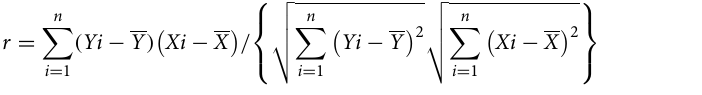
Figure 5. CaMKII phylogenetics (from 1D Sequences). ( a ). Metazoan CaMKII-AD evolution. Tree based on 1000 clustered homologs of the C. elegans CaMKII (black asterisk). Midge (pink asterisk). ( b ). Isoform evolution. Tree based on 2000 clustered homologs of the rat CaMKII α and β isoforms. Squares denote the most distant, larger CaMKIIα node (L) and the smallest y node with H:P ratios > H : P ± 2 s (1.5 ± 1.33), where H : P is the mean of the other nodes. Circles mark major clusters (diameter = membership; color = (i) phylum; (ii) isoform), Note difference in scale bar from that in Fig. S2C. ( c ) AD–KD coupling. The AD versus KD similarity plot compared the KD and AD phylogenetic trees color coded by isoform as in panel b (Box) The dual color symbols identify isoform pairs. The correlation coefficient, r = 0.59 with the best-fit (solid line) ± 95% confidence intervals (dashed lines). ( d ). Evolution of memory. Phylogenetic tree based on behavioral assays (from 39 ). Arrows show the major bifurcations associated with the emergence of homeotherms (blue) and primates (red). Box: The distribution of the poikilotherms (blue, cyan) and homeotherms (rouge, red, orange, salmon) kingdoms in the sequences of the δ isoform. ( e ). Phylogenetic Species Diversity: Species distributions for major nodes of the α, β and γ isoforms based on kingdom (i) and homeostasis (ii). Source listed in Table S1.